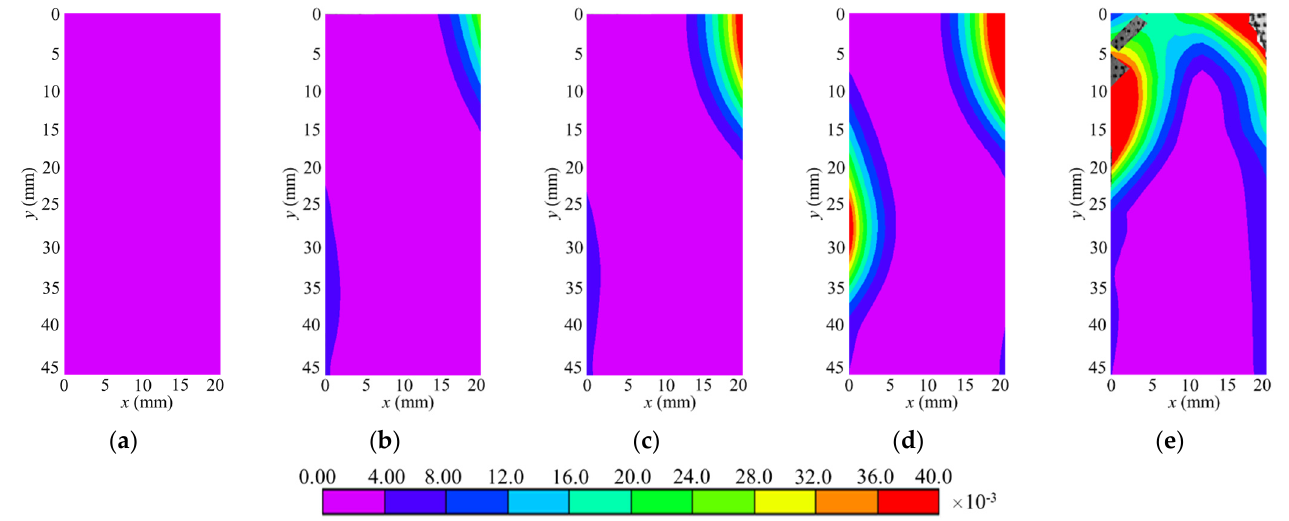
Figure 12. The principal strain fields corresponding to point ( a – e ) under different loading stages in Figure